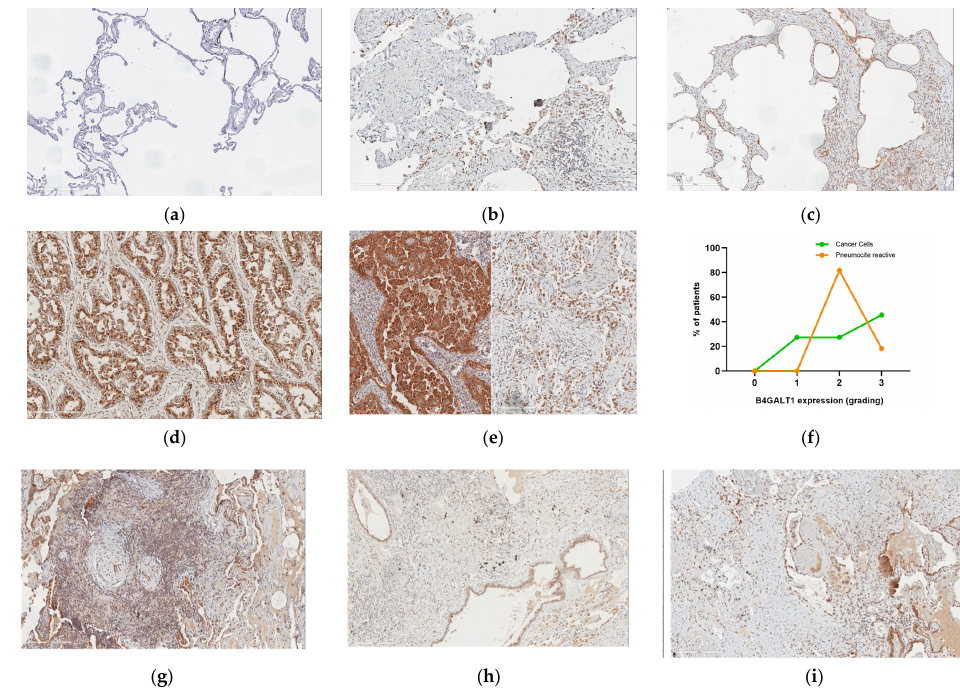
Figure 3. B4GALT1 expression in lung fibrosis and lung cancer ( × 20 magnification). ( a ) An example of near-normal lung tissue is shown (B4GALT1 staining); ( b ) positive staining in lung cancer; ( c ) tumor (on the left) and UIP (on the right) of the same patient show simultaneous strong cytoplasm B4GALT1 expression; ( d ) strong B4GALT1 expression is observed in most fibroblastic foci in UIP both in connective tissue and alveolar epithelium; ( e ) and possibly in UIP fibrous reactive remodeling of lung tissue not related to IPF; ( f ) quantification of grading expression of B4GALT1; ( g ) there are B4GALT1-positive immune lymphocyte infiltrating cells in neoplastic and UIP tissue samples; and ( h , i ) capillary endothelium expressing B4GALT1 was observed, in the same patient, both in the immediately peritumoral connective tissue area and adjacent to the UIP pattern